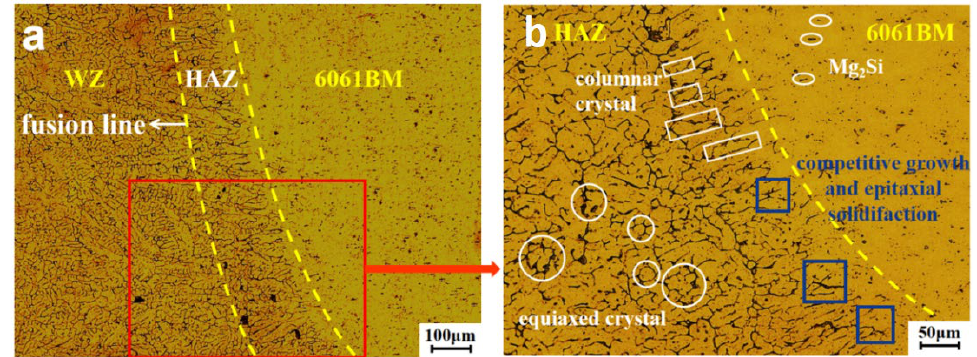
Figure 7. Microstructure of heat-affected zone near the aluminum alloy: ( a ) microstructure under 100 μm; ( b ) microstructure under 50 μm.